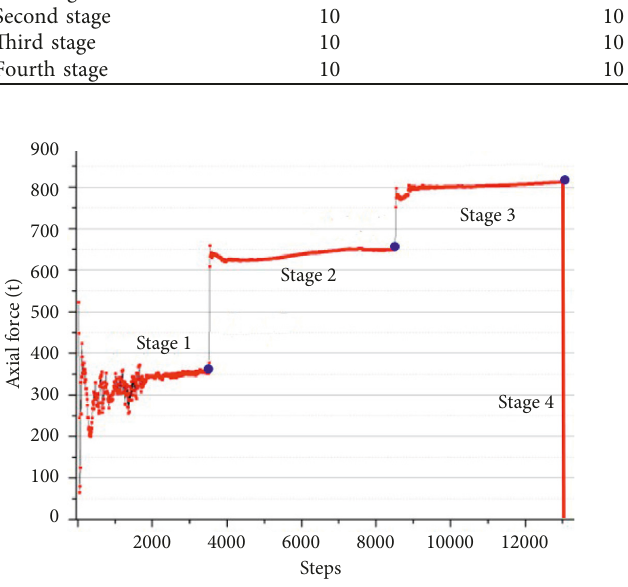
Figure 20: Stairs of axis force change of NPR anchor cables.